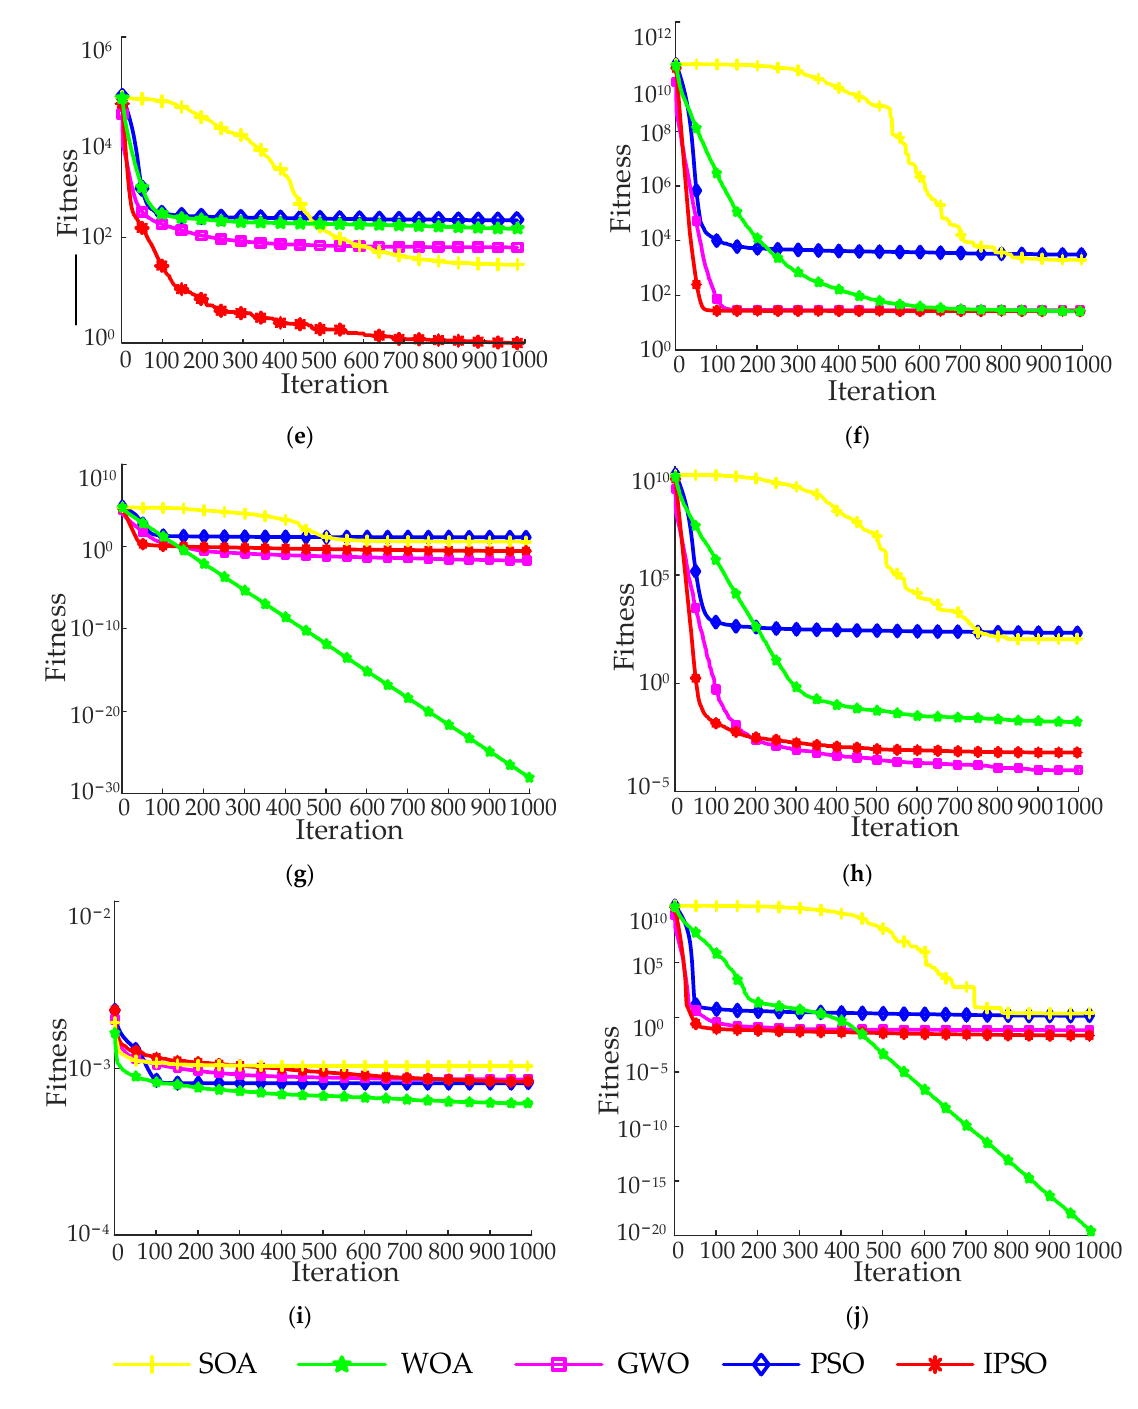
Figure 5. Average convergence curves of 10 benchmark functions. ( a – j ) represent the average con ‐ vergence curve of function f 1 – f 10 . convergence curve of function f 1 – f 10